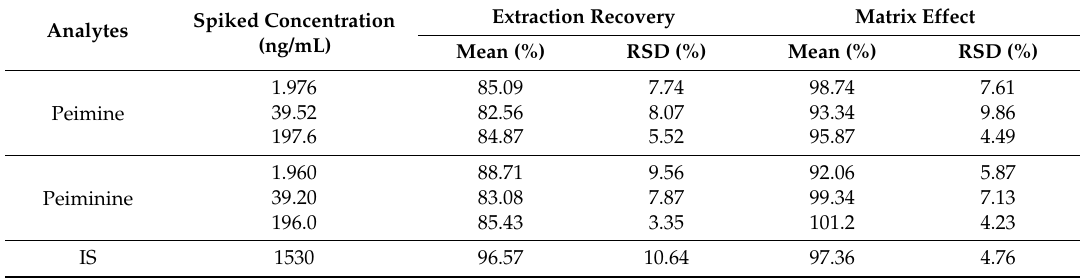
Table 4. Extraction recoveries and matrix effects for the analytes and I.S. in beagle dog plasma ( n = 6). Analytes Spiked Concentration (ng/mL)